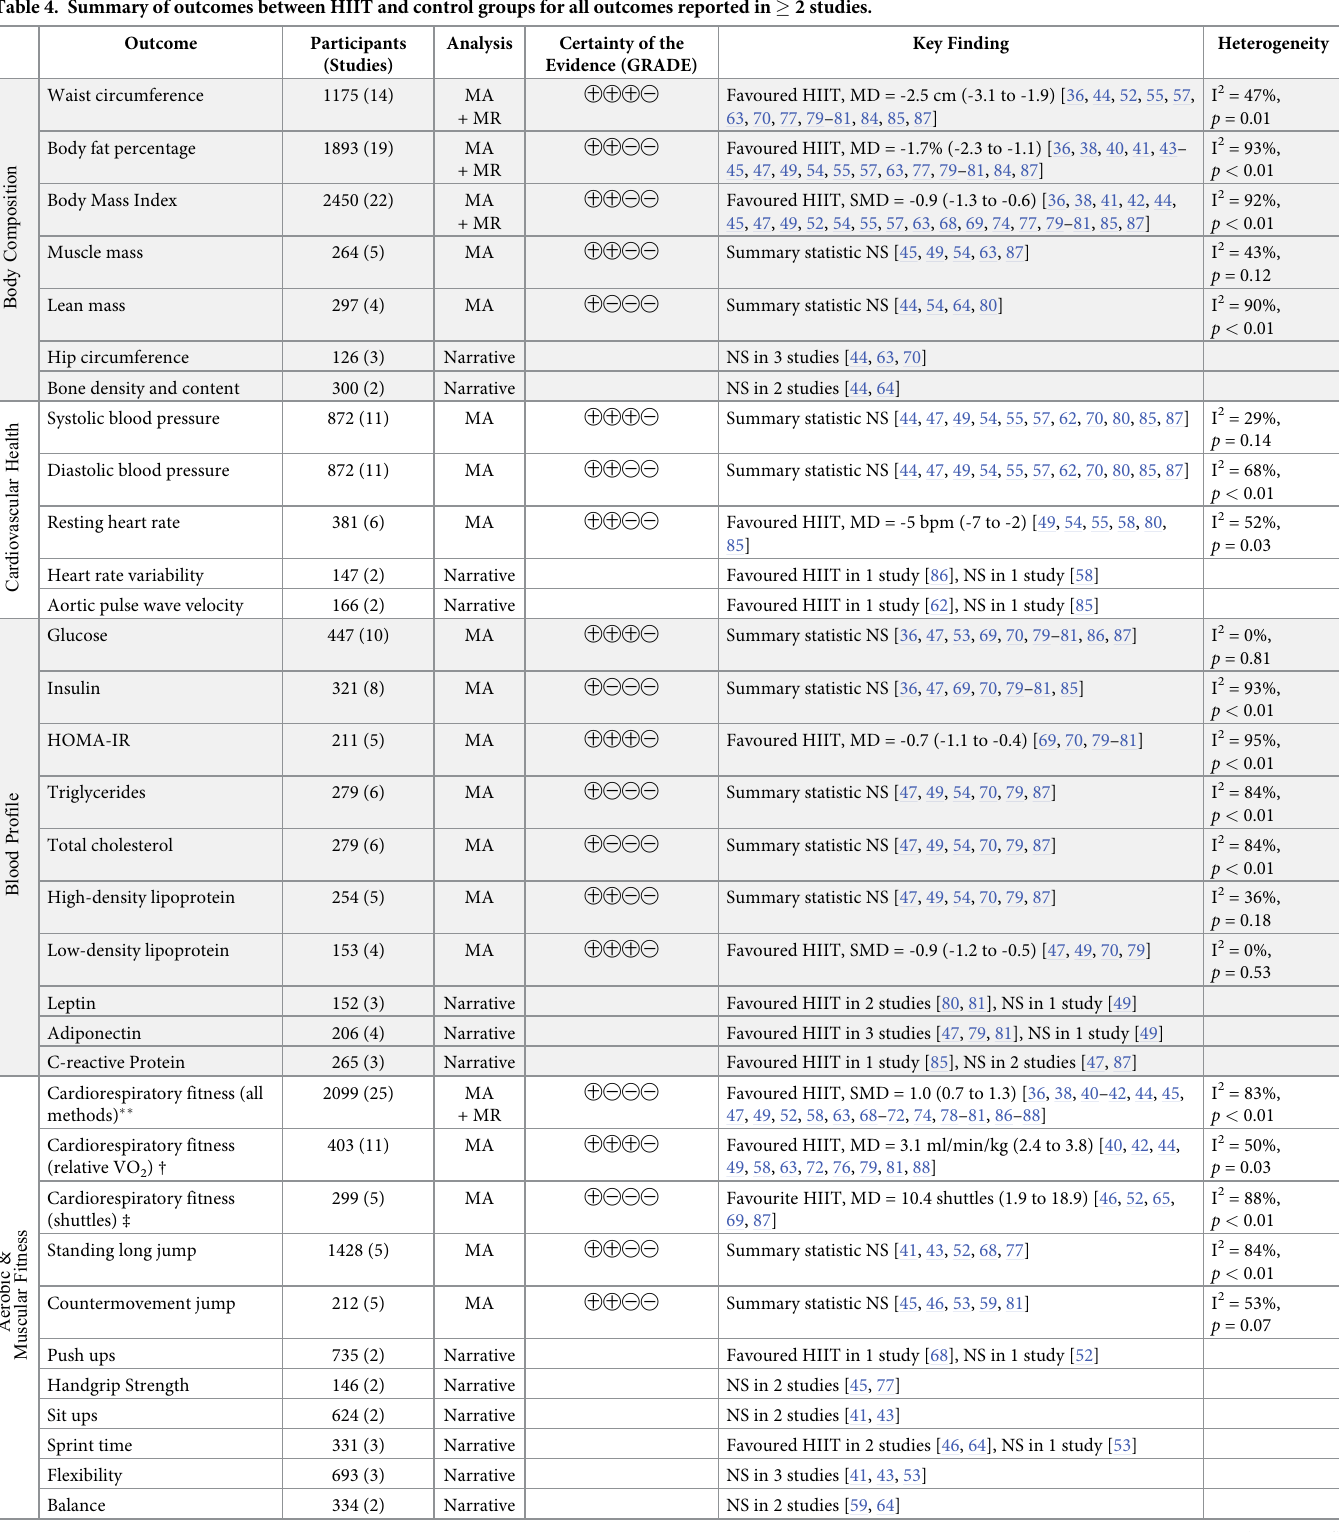
Table 4. Summary of outcomes between HIIT and control groups for all outcomes reported in � 2 studies.